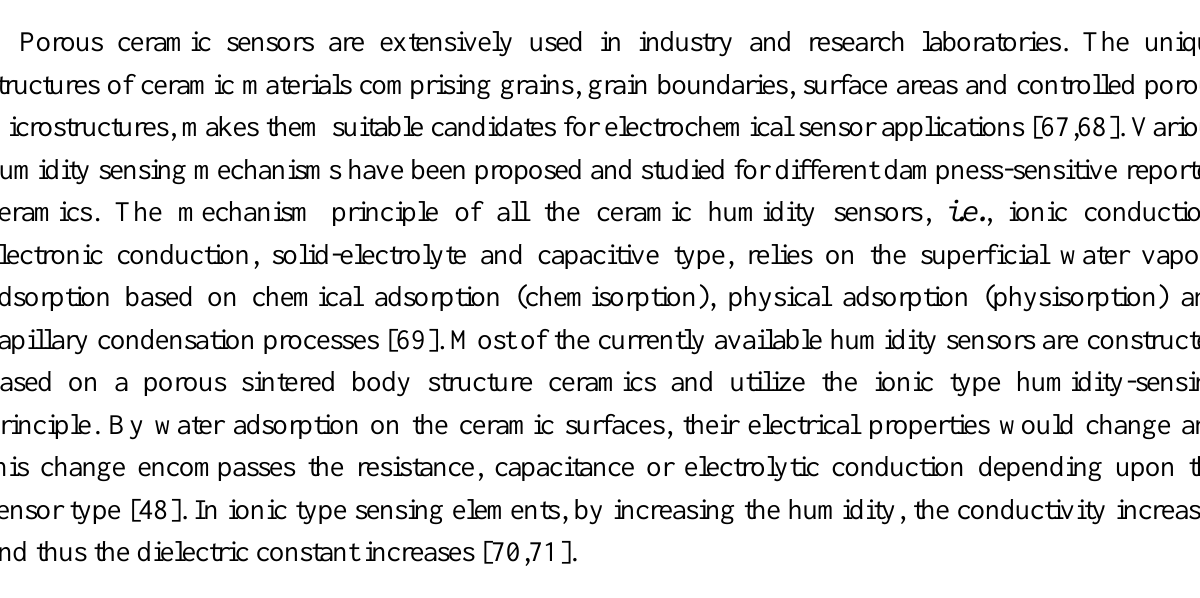
Figure 1. Proton conduction of the H-bonded networks between water molecules [74]. The express substitution of hydrogen (H + ) between hydronium cation (H molecule (H O) without diffusive action of an individual hydrogen or oxygen 2